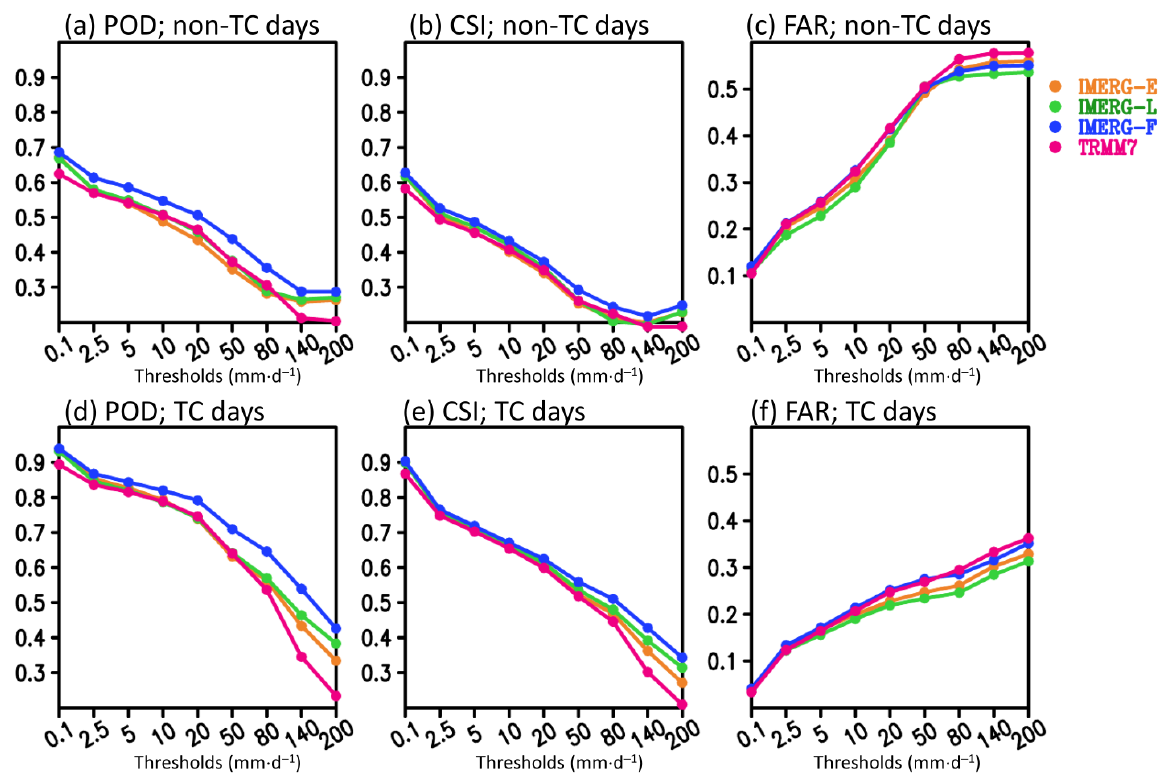
Figure 6. Statistical evaluations based on non-TC days in Taiwan during 2000–2018 JASO: ( a ) probability of detection (POD), ( b ) critical success index (CSI), and ( c ) false alarm ratio (FAR). ( d – f ) are similar to ( a – c ), respectively, but for statistical evaluations based on TC-days in Taiwan during 2000 – 2018 JASO.